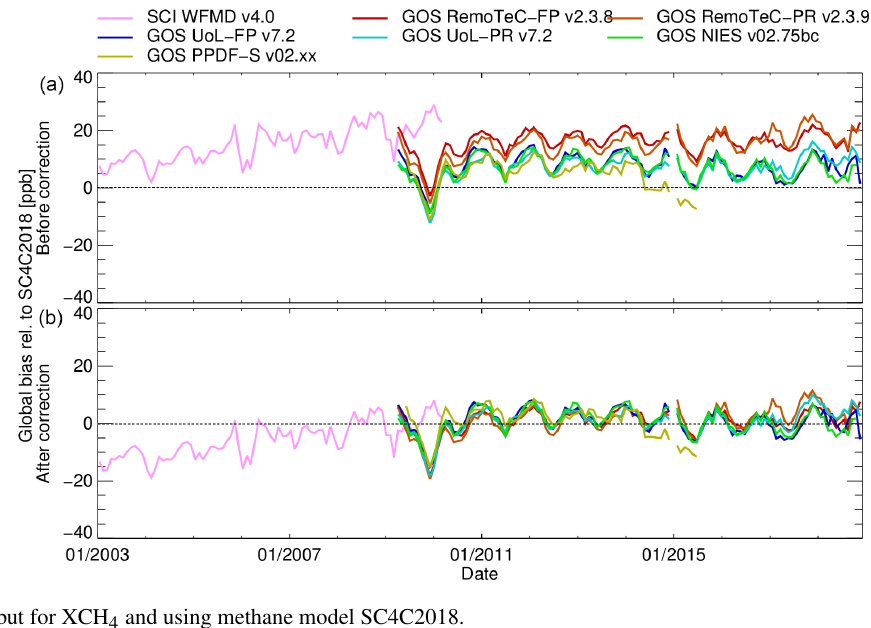
Figure 7. As Fig. 5 but for XCH 4 and using methane model SC4C2018.